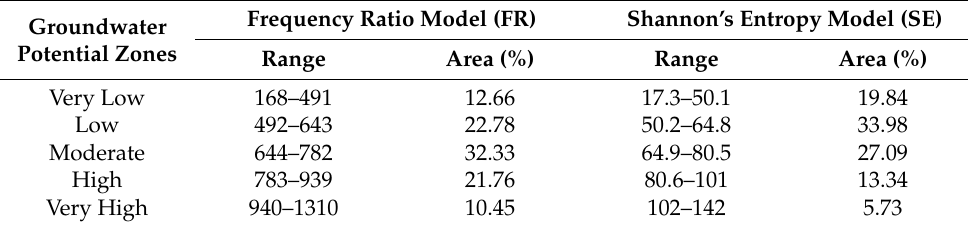
Figure 14. Groundwater potential map by Shannon’s entropy (SE) model. Table 2. Distribution of the groundwater availability classes and areas covered by each of these classes.